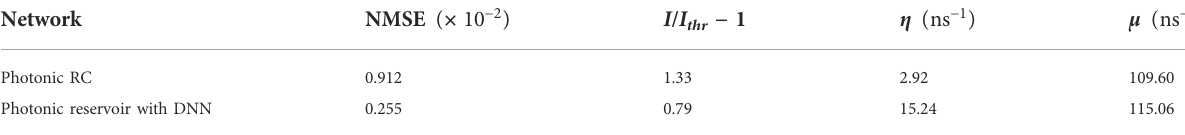
TABLE 3 OptimalNMSE and reservoir parameters for the photonic RC system andthe reservoircombined with the DNN (trained for 1.6 ×10 4 epochs), on the Santa Fe one-step ahead prediction task. Network